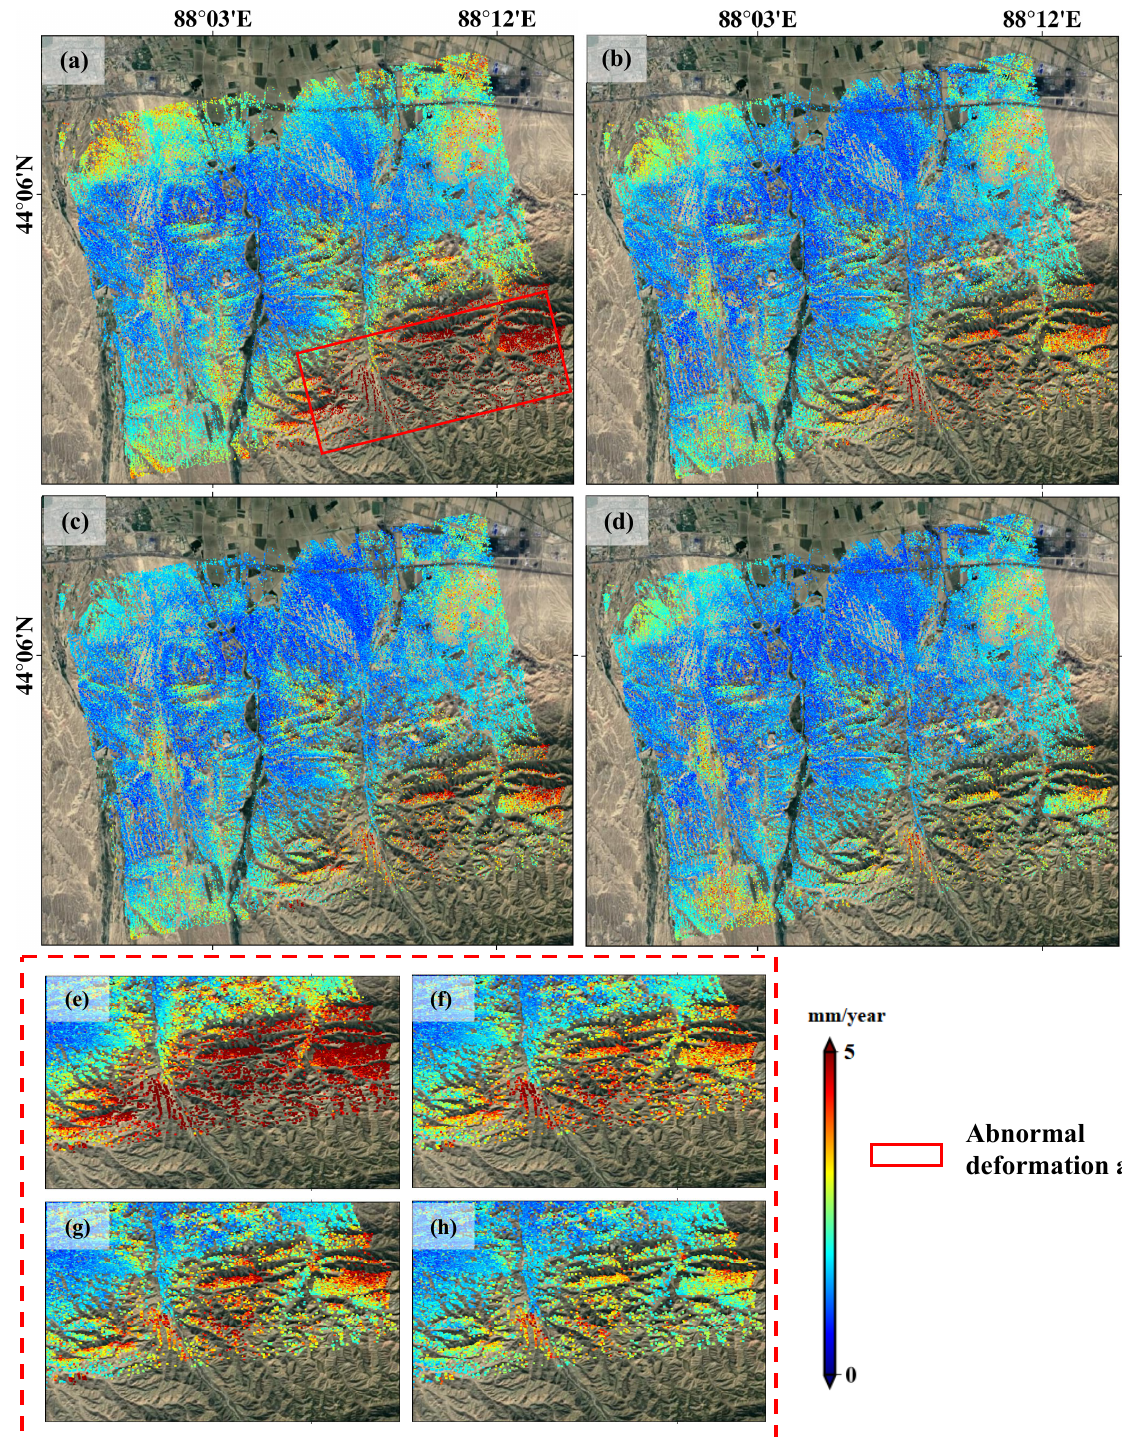
Figure 10. Standard deviation of the LOS velocity. ( a – d ) are the results of Original Stacking-InSAR, Original ERA5-Corrected Stacking-InSAR, Effective ERA5-Corrected Stacking-InSAR and adaptive ERA5-Corrected Stacking-InSAR, respectively. ( e – h ) are the areas in the red boxes of ( a ) corresponding to the magnification of the results of ( a – d